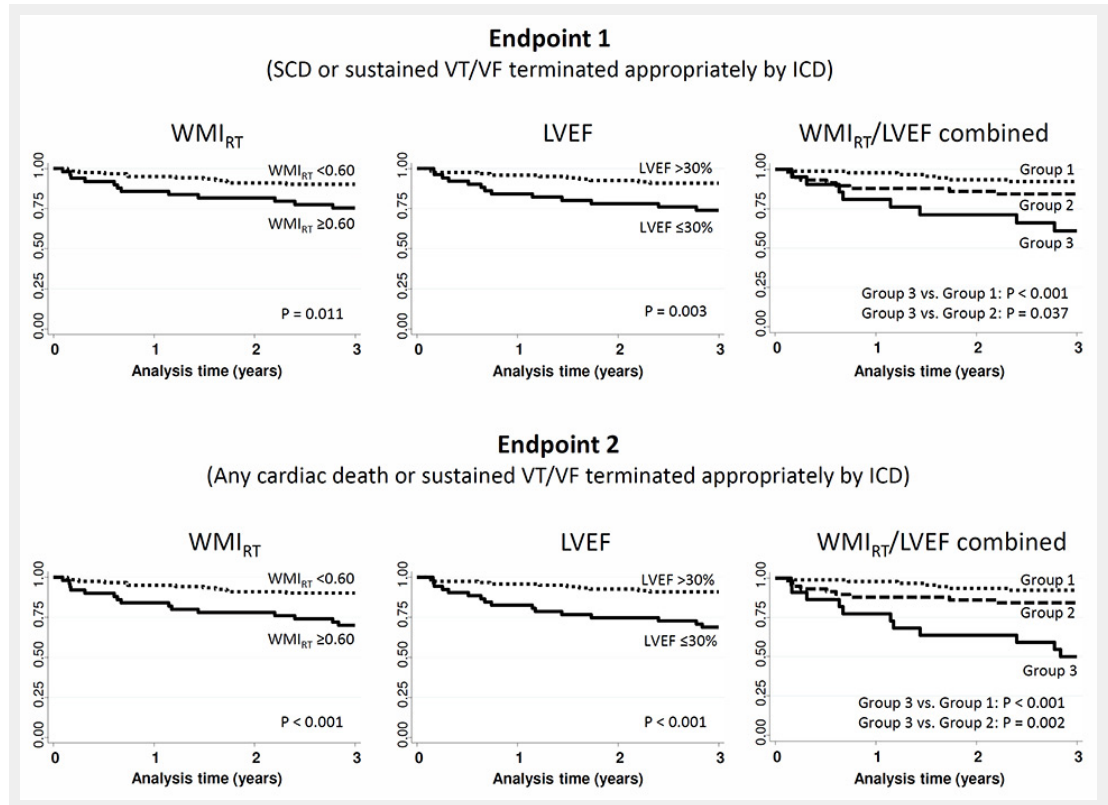
Figure 3 Kaplan-Meier survival estimates for Wedensky modulation index (WMI RT ), left ventricular ejection fraction (LVEF) and the combination of both predictors (Group 1 = WMI RT <0.60 and LVEF >30%; Group 2 = WMI RT ≥0.60 or LVEF ≤30%; Group 3 = WMI RT ≥0.60 and LVEF ≤30%). ICD = implantable cardioverter-defibrillator; SCD = sudden cardiac death; VT/VF = ventricular tachycardia / ventricular